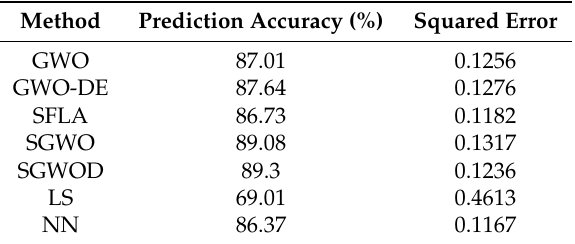
Table 8. The prediction